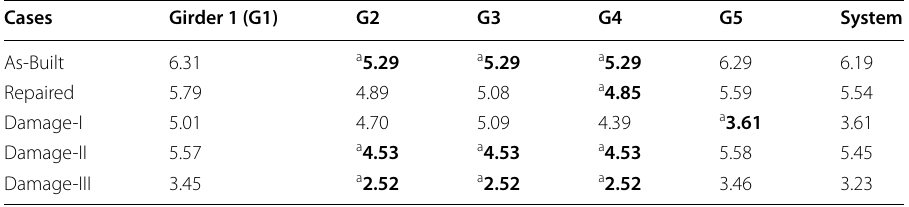
Table 5 The component reliability values of each girder and the system reliability values for each case are shown ( a controls the component reliability) Cases